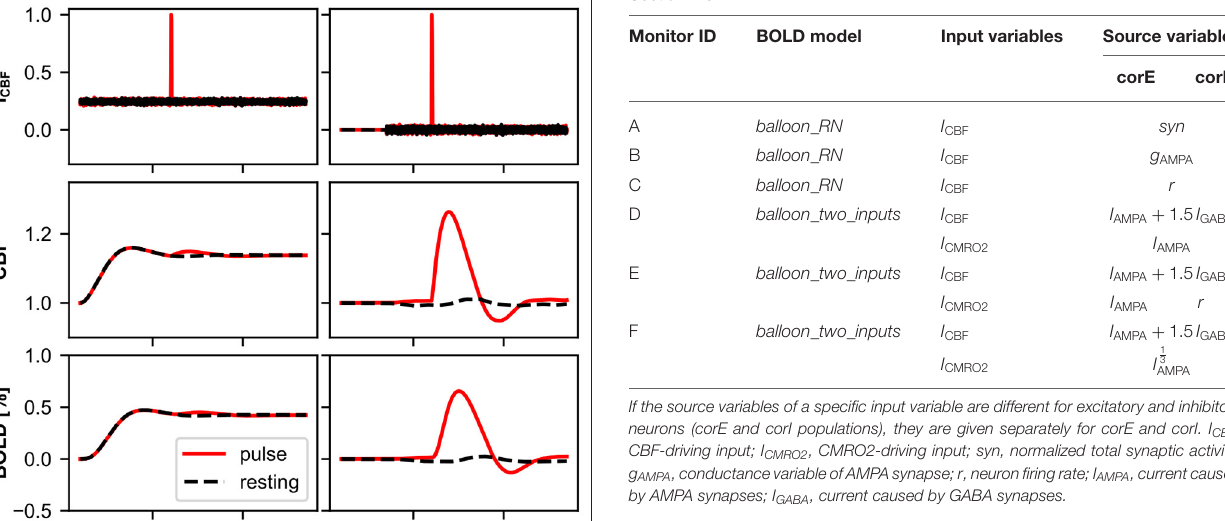
TABLE 1 | The input and source variables of the 6 different BOLD monitors of Section